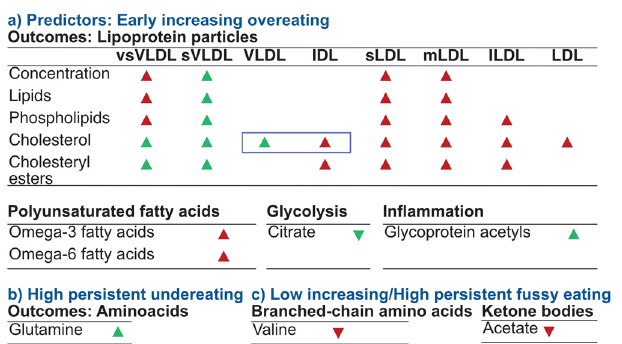
Figure 5. Overview of significant associations between eating trajectories and metabolic markers and their mediation through body mass index (BMI) at age 12 years in the Avon Longitudinal Study of Parents and Children (ALSPAC, n = 3104). Arrows in upward direction indicate that the metabolic marker is measured to be higher in children with either high and persistent overeating, undereating, or fussy eating compared with children that are not reported by their parents to engage in any of these eating behaviours. A red arrow indicates that the eating behaviour is associated with the higher metabolite independent from the adolescents’ body mass index (BMI) at age 12 years compared to the reference category. Green arrows indicate that the association is mediated through BMI at age 12 years. The blue square indicates remnant